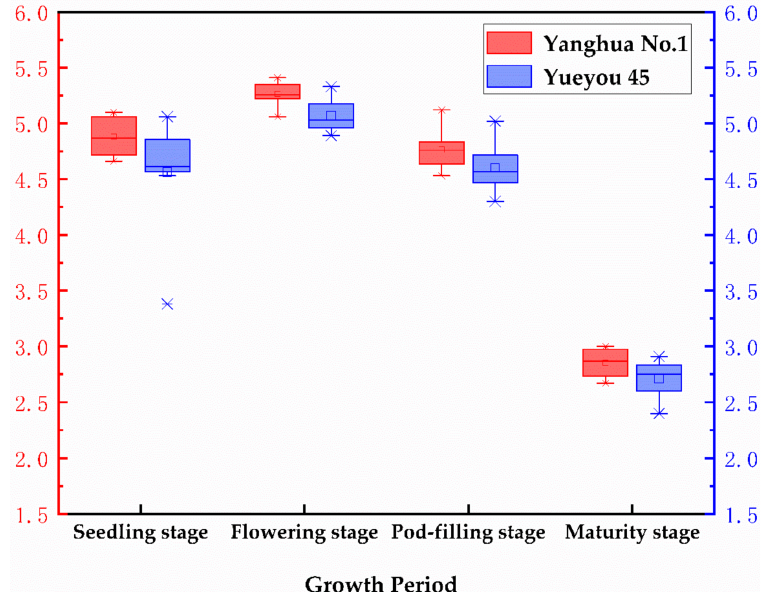
Figure 4. Changes in LAI throughout the growing period in two peanut varieties; p = 0.01, the correlation is significant.